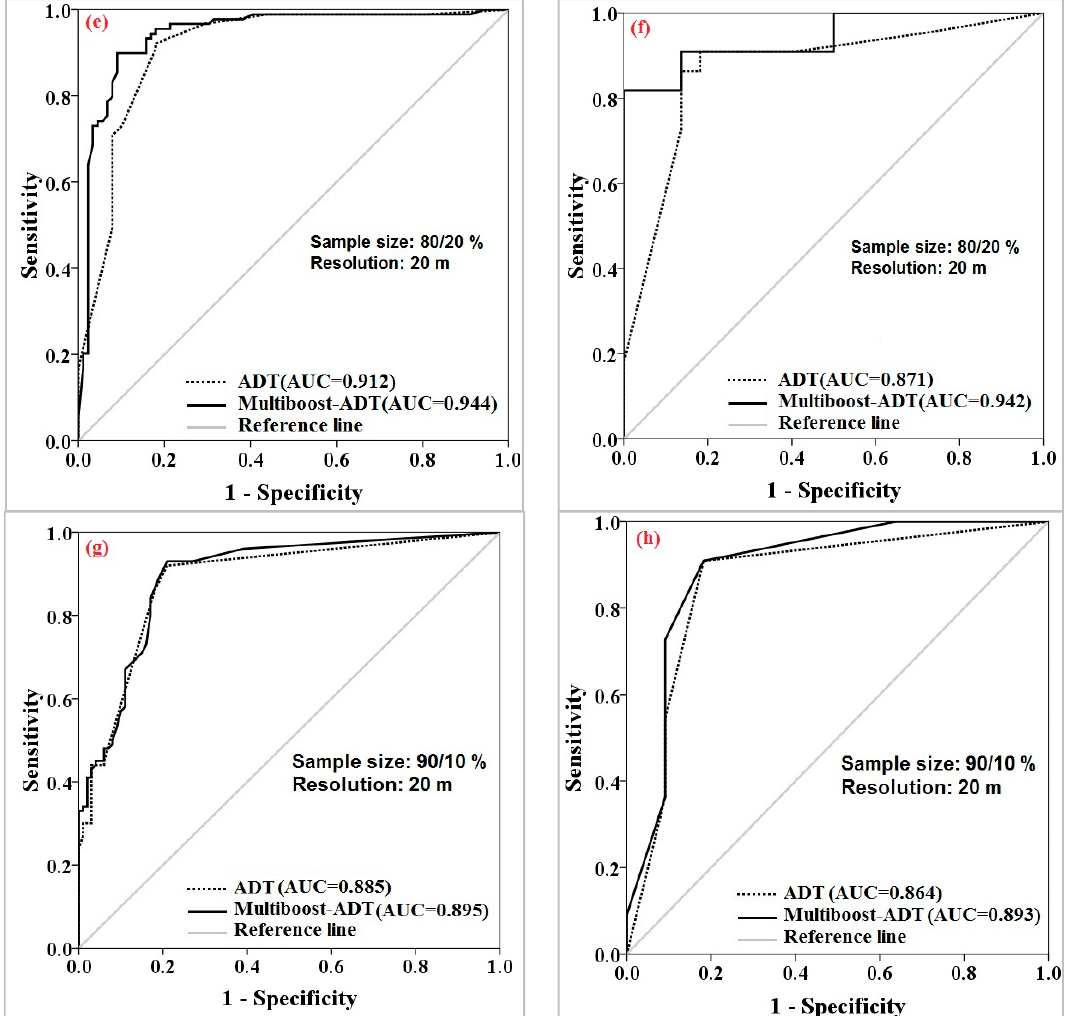
Figure 7. Model comparison and evaluation of the ADTree and its ensembles in different sample sizes and raster resolutions using: training dataset ( a , c , e , g ); and validation dataset ( b , d , f , h ).